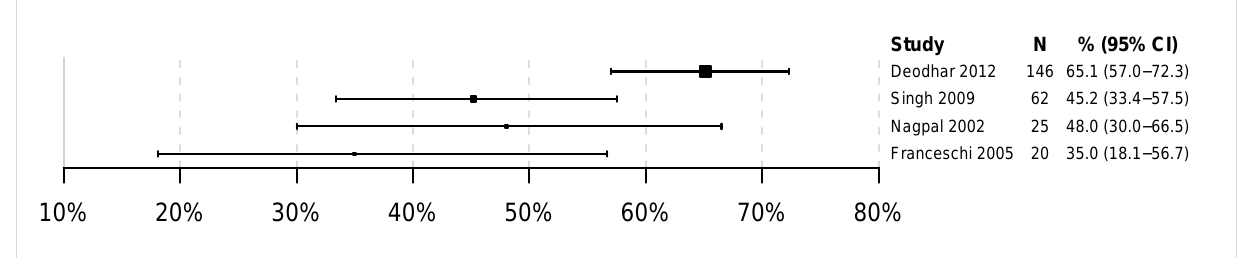
Figure 58: HPV 16 prevalence among women with high-grade cervical lesions in India, by